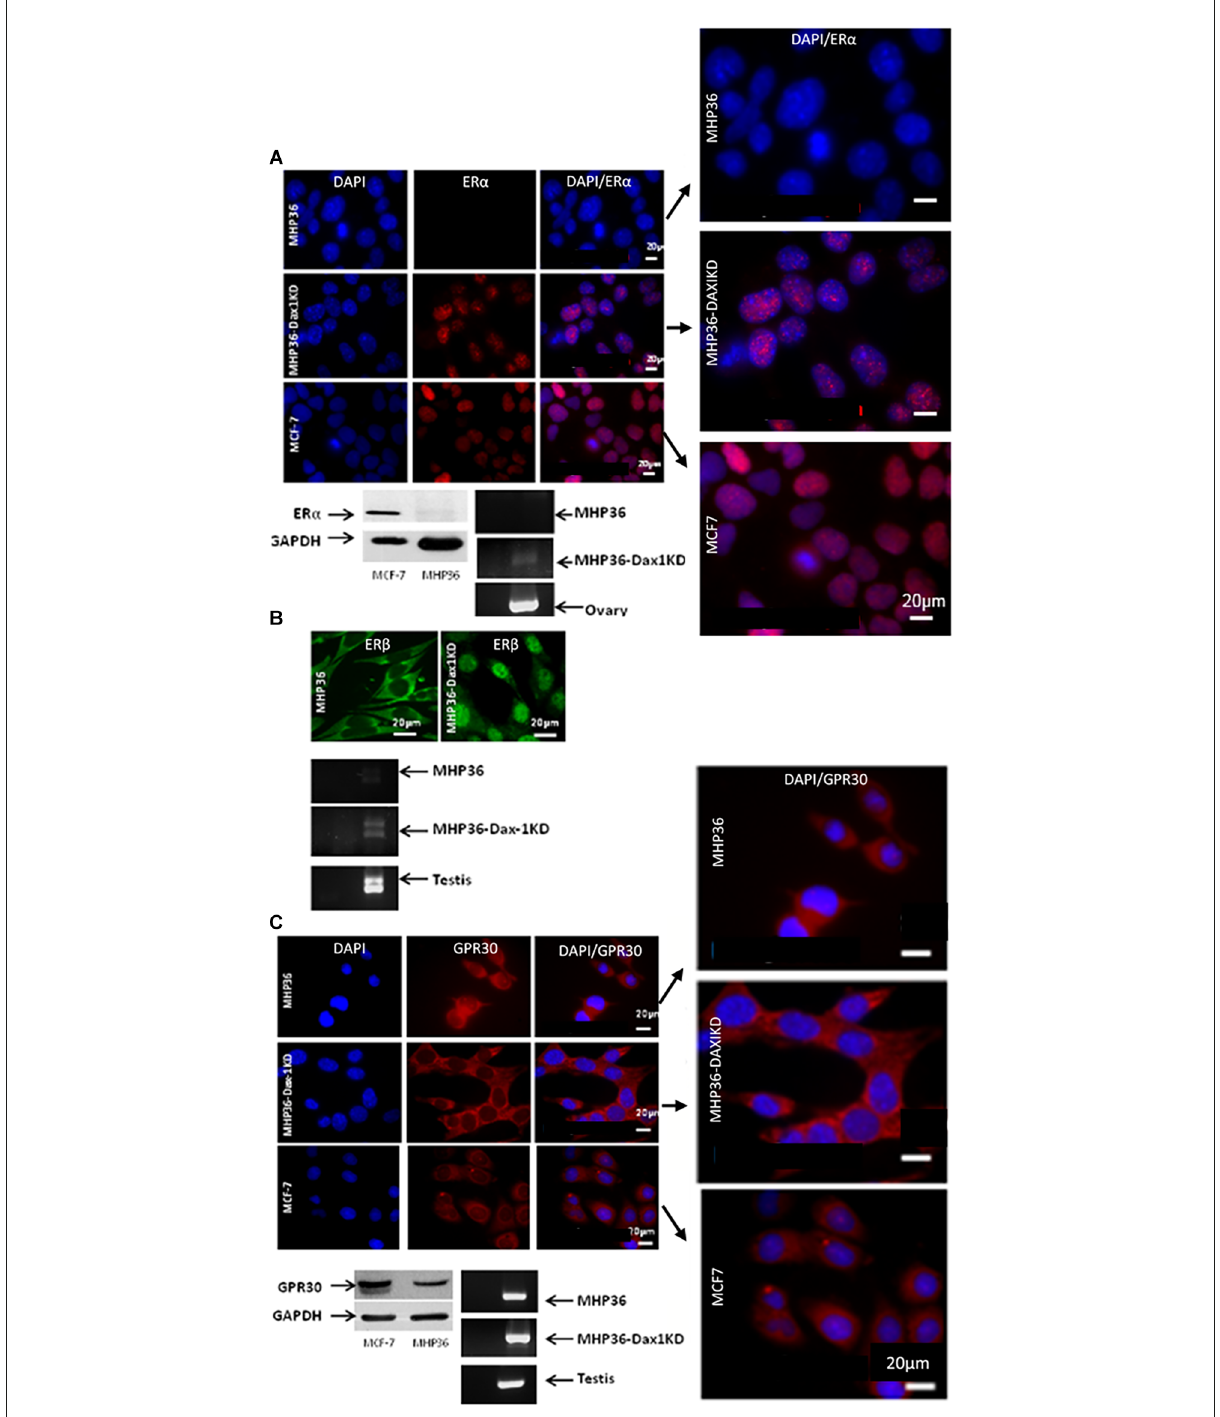
FIGURE2 Characterizing the MHP36 and MHP36-Dax1KD for estrogen receptors (ER). (A) Immunofluorescence staining (top panel) for ER α in MHP36, MHP36-Dax1KD, and MCF-7 cells (positive for ER α ; Bars: 20 µ m), with co-localization shown in enlarged images. Western blotting (bottom left panel) and RT-PCR (bottom right panel) confirming immunostaining results, ovary used as positive for ER α . (B) Immunofluorescence staining (top panel) for ER β in MHP36 (cytoplasmic staining) and MHP36-Dax1KD (nuclear staining) cells (Bars: 20 µ m). RT-PCR (bottom panel) confirming immunostaining results, testis used as positive for ER β . (C) Immunofluorescence staining (co-localization shown in enlarged images) and Western blotting (top and bottom left panel) for GPR30 in MHP36, MHP36-Dax1KD, and MCF-7 cells (positive for GPR30; Bars: 20 µ m). RT-PCR (bottom right panel) confirming immunostaining results, testis used as positive for GPR30 (representative images of n =